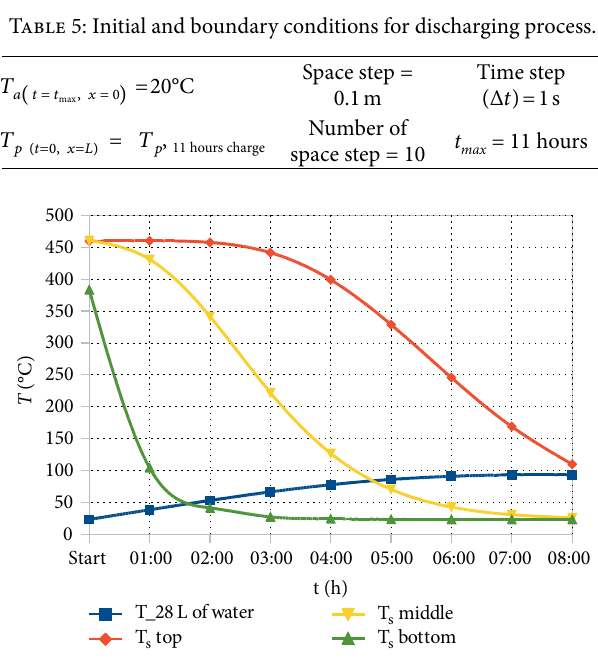
Figure 17: Temperature of thermal storage and 28 liters of water during discharging with 0.0048 kg/s mass flow rate of air for the higher